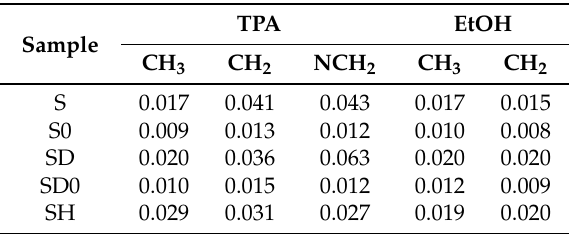
Table 4. T CH cross-polarization times (in s) 1 of the resonances obtained for TPA and ethanol in the different samples. TPA EtOH Sample CH